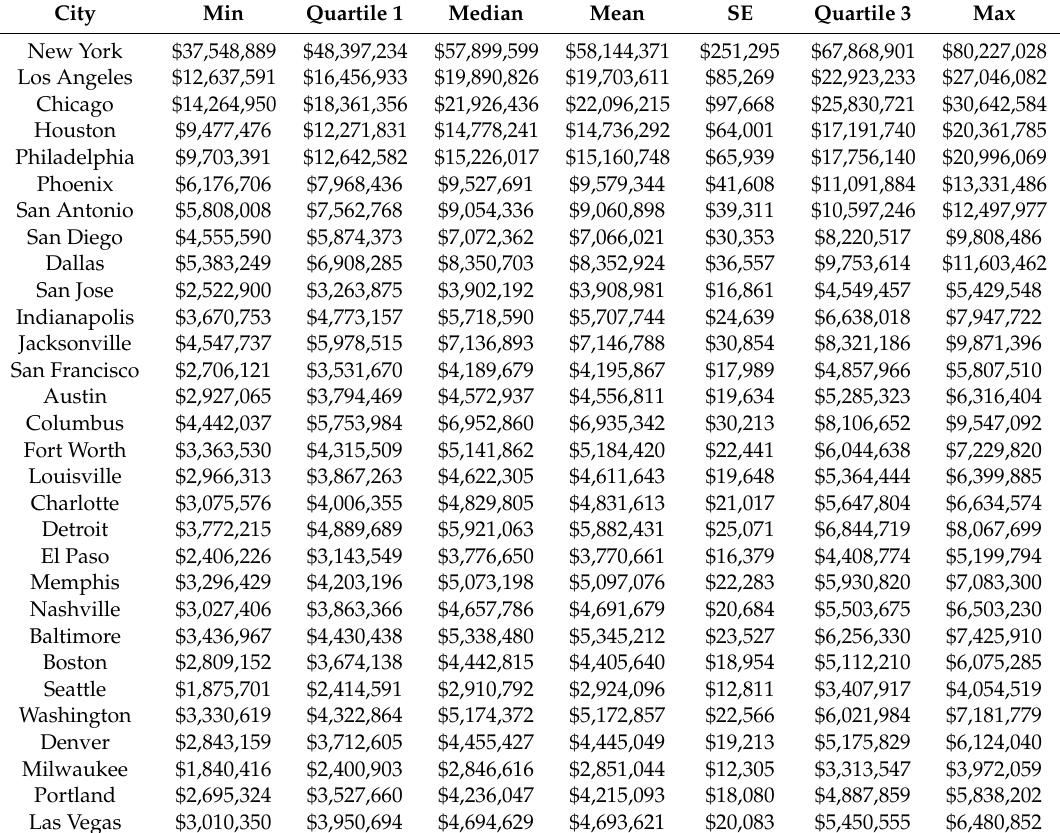
Table A1. Location statistics and measures of center by